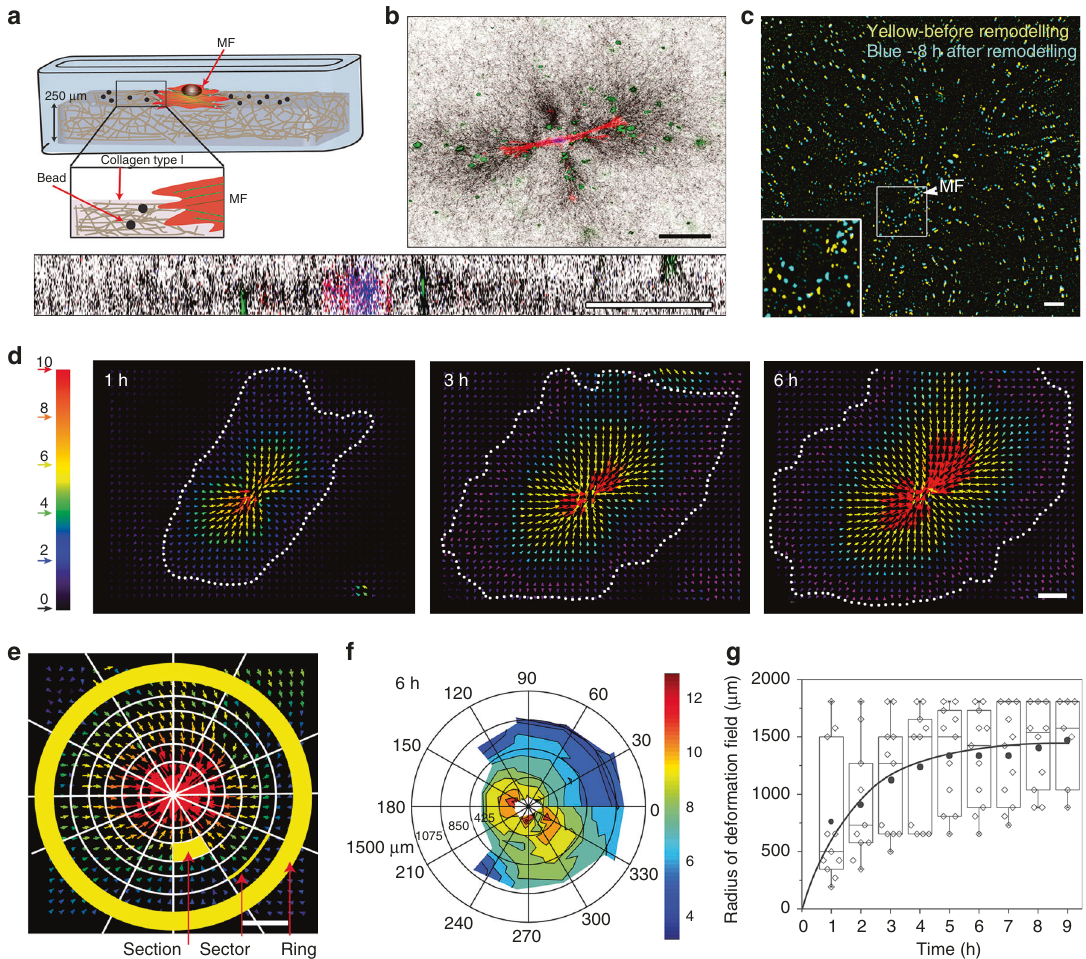
Fig. 1 Myo fi broblasts (`MFs) generate far reaching deformations in fi brillar collagen extracellular matrix (ECM). a Schematic of the experimental set-up. b Confocal re fl ection and fl uorescence microscopy of the experimental set-up. Single MFs (F-actin, red) were attached to the top of fi brillar collagen ECM provided with surface marker beads (green) and allowed to remodel the ECM (re fl ection, black) for 3h. Side view z -scanning (bottom) demonstrate the position of beads and MFs on the collagen surface. c MF contraction of ECM was quanti fi ed by analyzing position changes of marker beads over time, here shown in overlay before contraction (yellow) and after 8h of ECM remodeling (blue) by MFs (position indicated by arrowhead). d Marker displacements were used to calculate MF-induced deformation fi elds using particle image velocimetry, displayed as vectors with color-coded magnitudes as indicated (red — high displacement). Deformation fi eld boundaries were de fi ned by displacement vector amplitudes ≤ 1 µ m (dotted lines). e Breakdown of the deformation fi eld into rings, sections, and sectors allowed computation of average vector magnitudes as a function of distance and direction from the contractile MF. f Such averages were used to align obtained deformation fi elds along their long axis and generating the overall average after 6h remodeling (11 macrophages, 11 experiments) with color-coded magnitudes. g The radii of all MF-induced deformation fi elds were measured over time and medians are shown as center lines of box (25th to 75th percentiles) and whisker (minimum to maximum) plots; black circles and continuous are averages with exponential fi t. All scale bars: 100 µ